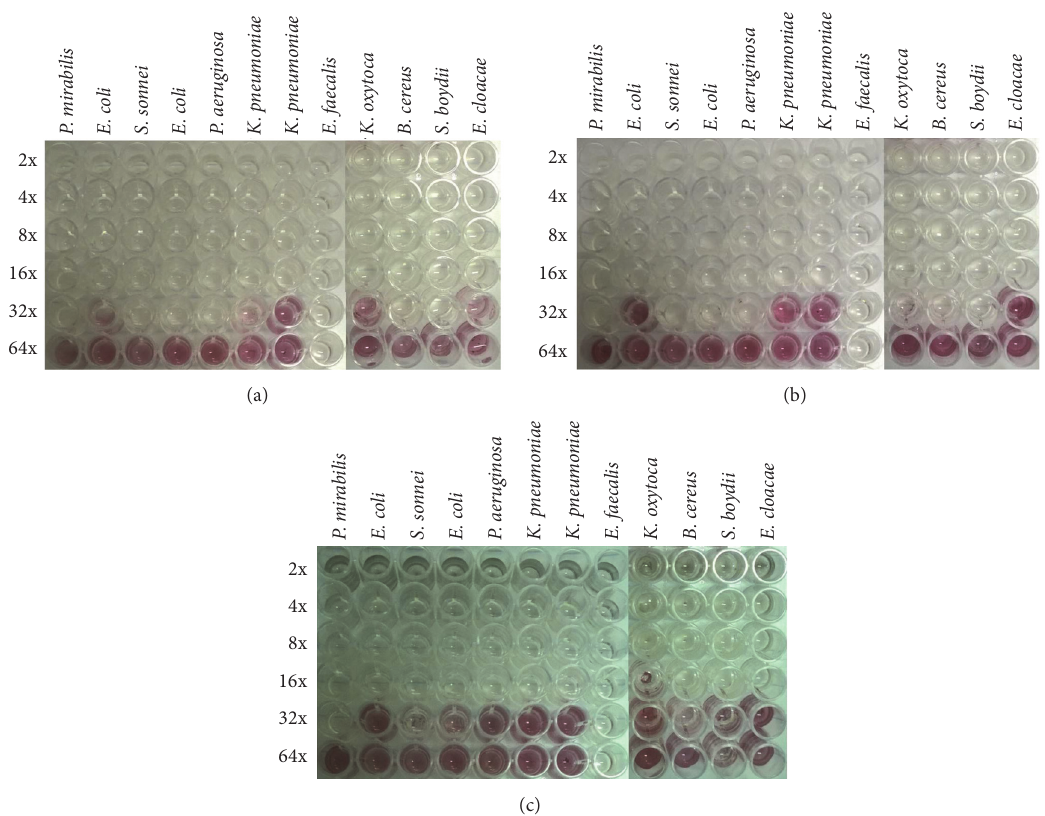
Figure 7: The antimicrobial effect of chitosan (a), chitosan-alumina (b), and chitosan-alumina/f-MWCNTs (c) on various strains of bacteria. Clear wells indicated that there was no growth/inhibition of the bacteria. Purple wells indicate growth (no inhibition) of the bacteria.